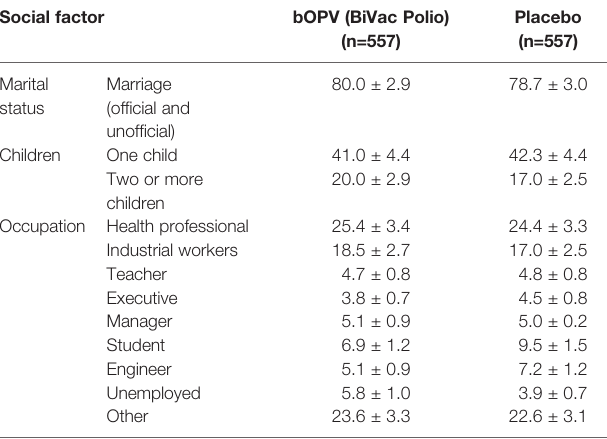
TABLE 2 | Socio-demographic characteristics of study